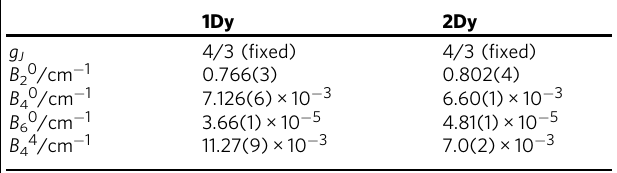
a From a fi t of luminescence, INS, and powder magnetization data to Eq.